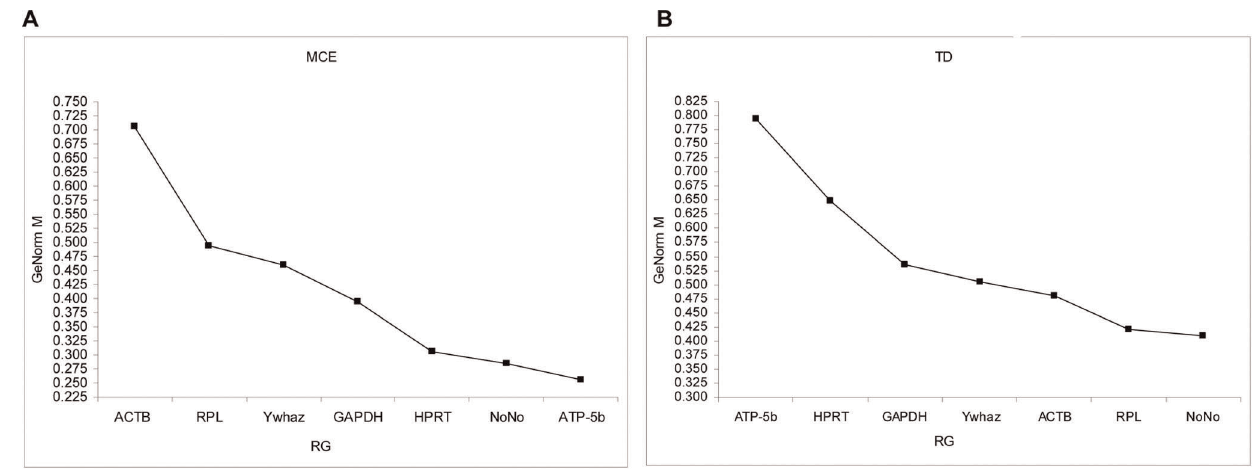
Figure 2. Expression stability values of candidate RGs during MCE and TD assessed by GeNorm. qPCR gene expression analysis was carried out on cDNA derived from differentiating cells. Gene expression data were converted to relative expression using the relationship (E + 1) 2 D Ct and data was analyzed using GeNorm algorithm, yielding the rank order of gene expression stabilities during MCE (A) and TD (B). M, the average stability measure, was determined for each candidate RG. RGs with the lowest M are considered as most stable.